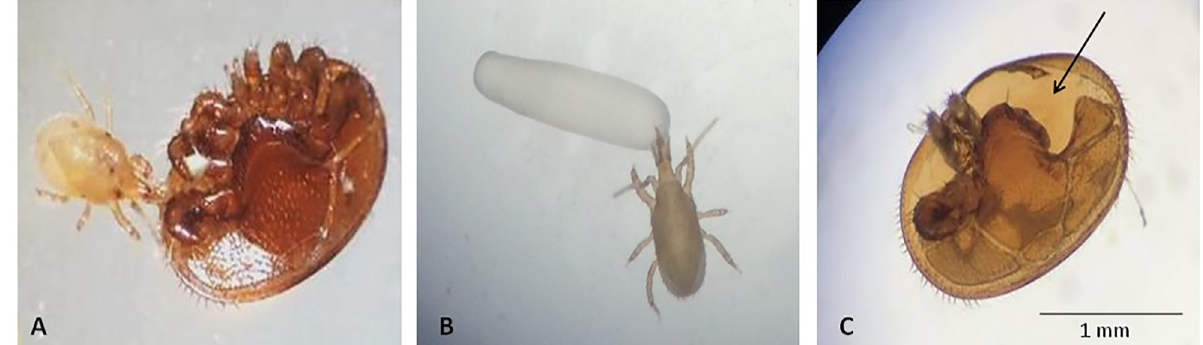
Fig 2. The predatory mite Stratiolaelaps scimitus feeding on a female Varroa mite (A) and a honey bee egg (B) under laboratory conditions. After being attacked by S . scimitus , the Varroa showed characteristic signs of predation (C) such as missing legs and holes in the cuticle (arrow) . (Photos: Sabrina Rondeau,